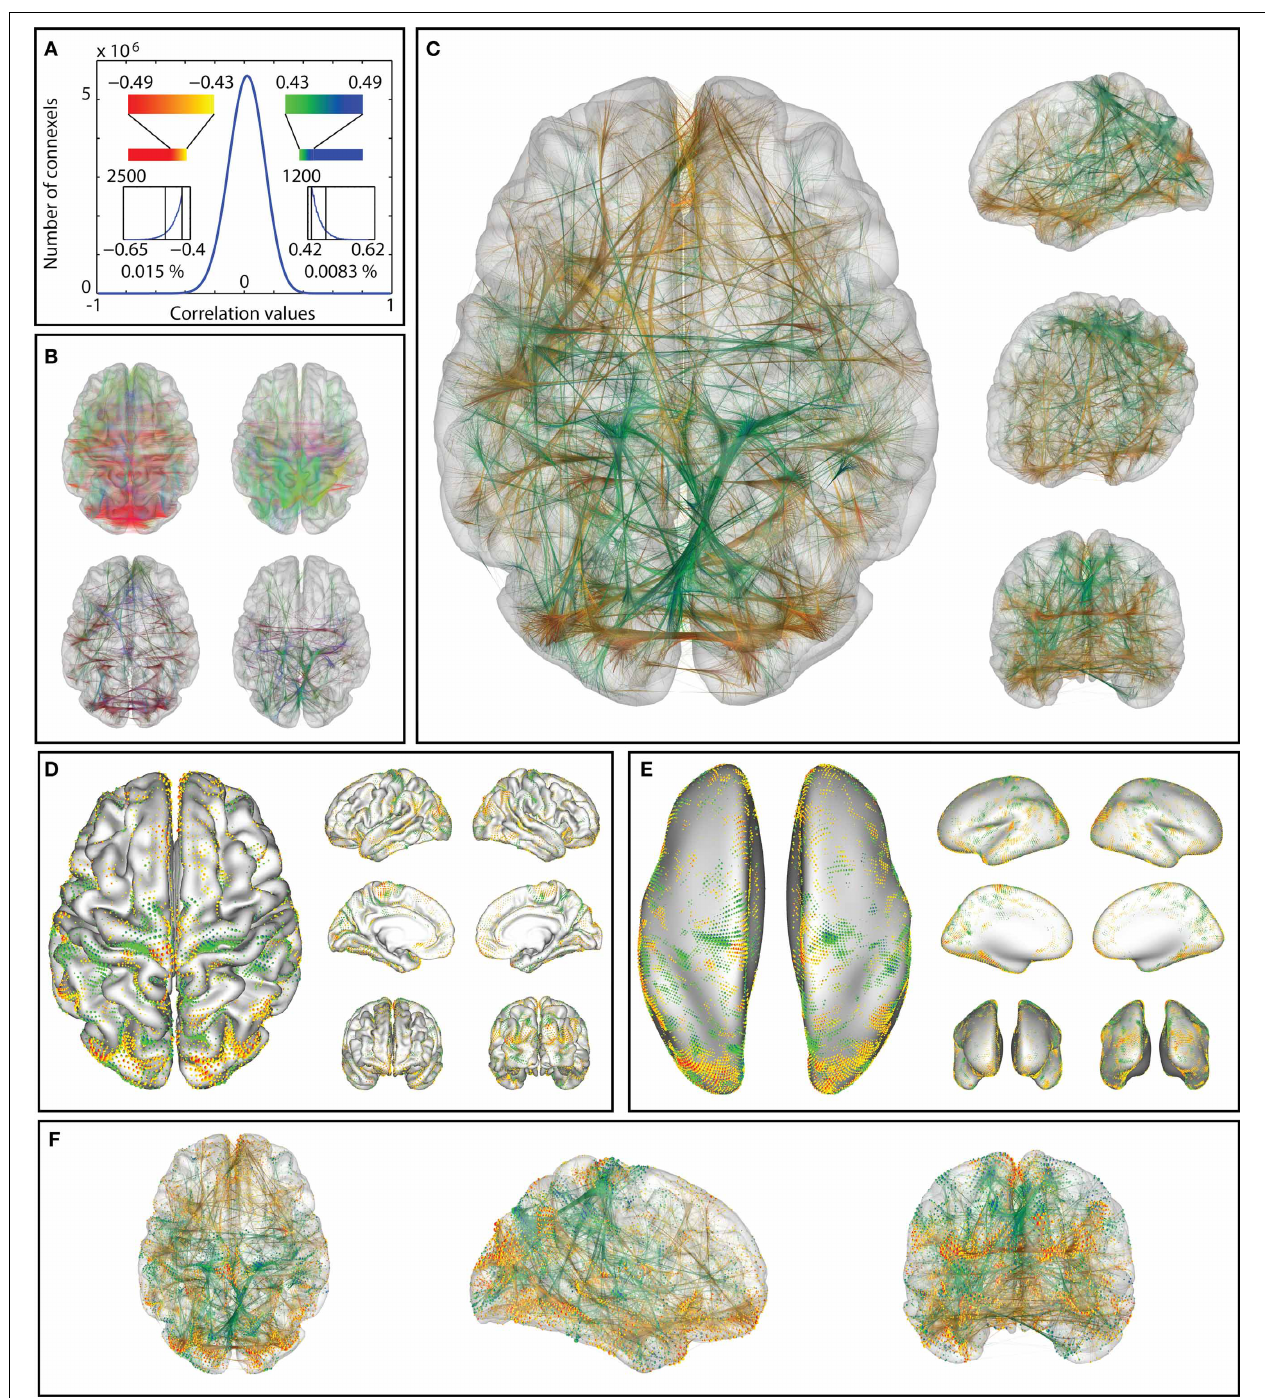
FIGURE 13 | Correlations between age and functional connectivity-based connexels in a group of 65 participants: the distribution of correlation values (A) is thresholded (at ± 0.43, minimum length 20mm). The remaining connections (B) vary strongly with age: The thresholded connexels in (b, right) gain connectivity strength over age, while the connexels in (B left) decrease in value (color represents orientation with xyz mapped to rgb). Edge-bundling (B,